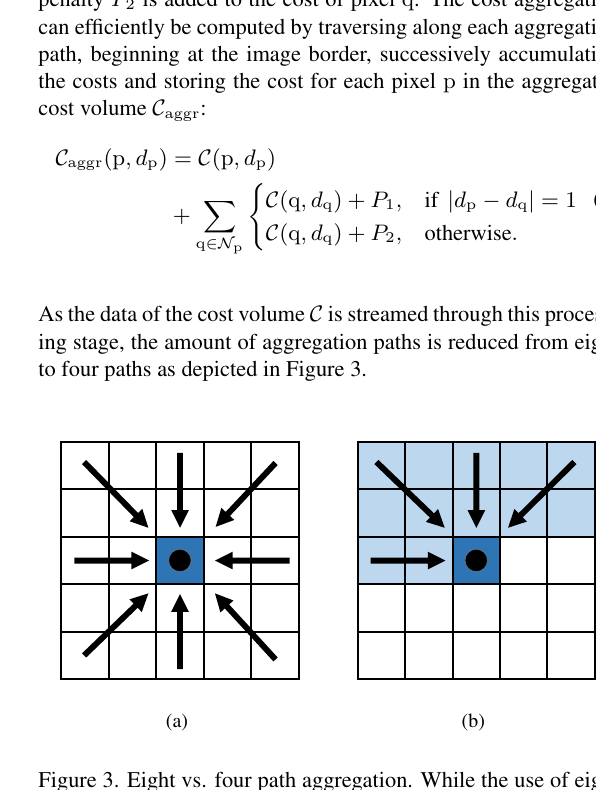
Figure 3. Eight vs. four path aggregation. While the use of eight paths (a) require full image access for each pixel being aggre- gated, the use of only four paths (b) can efficiently be computed while streaming the pixel data and accumulating previously com- puted costs (light